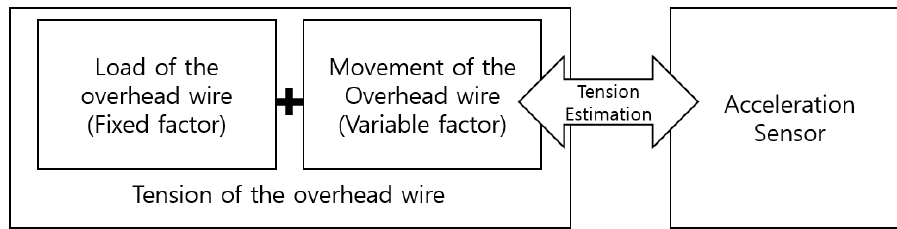
Figure 1. The theoretical background of the estimation of the tension for the overhead wire.